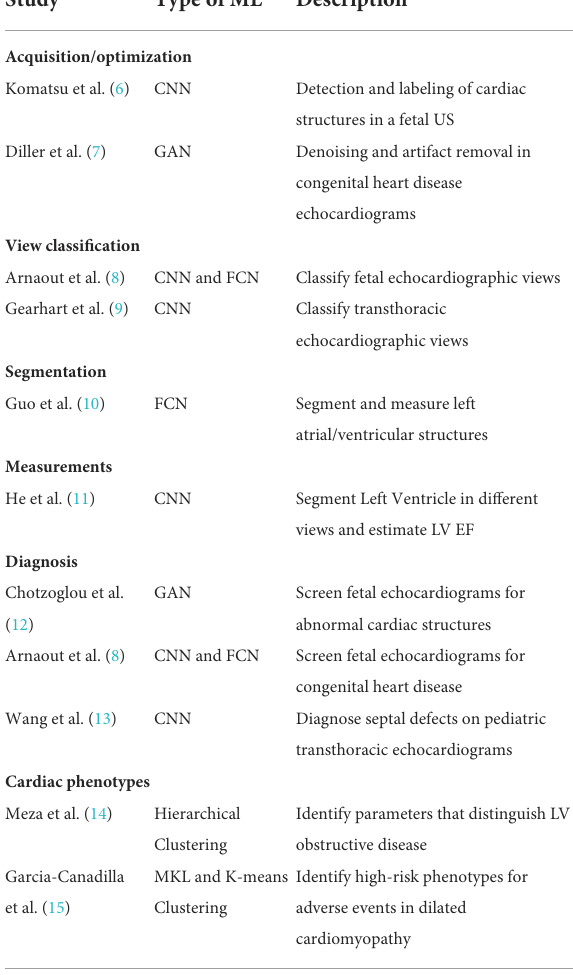
TABLE 1 Key AI literature in pediatric